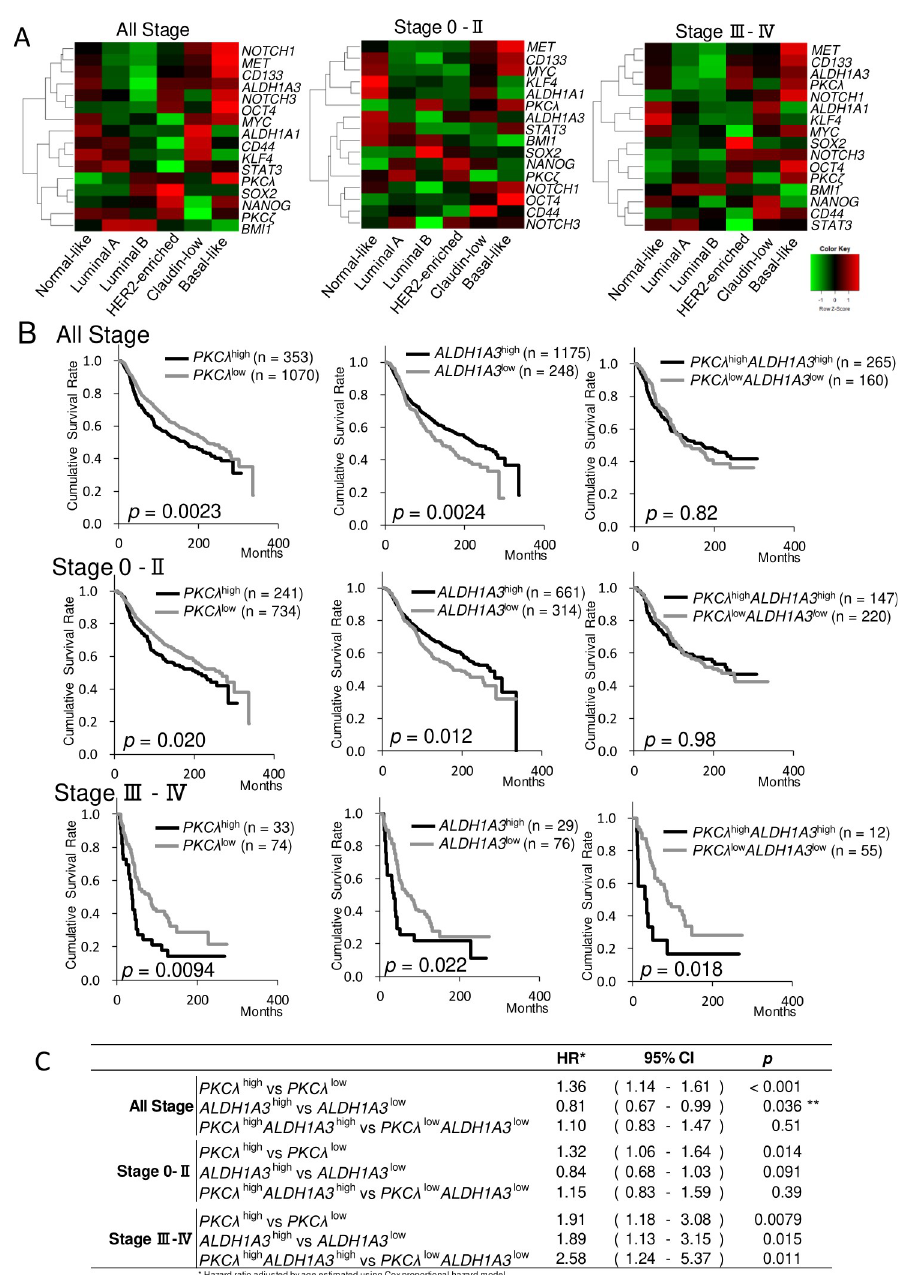
Fig 2. High expression of PKC λ and ALDH1A3 contributes to poor clinical outcomes in breast cancer patients. (A) Heatmaps of the average levels of PKC λ , PKC z , and stemness gene expression (z-score) in breast cancer PAM50 subtypes in the METABRIC dataset at several tumor stages. Raw z-scores were recalculated based on the average values. In the heatmap, red and green represent upregulated and downregulated genes, respectively: left panel, all stages; center panel, stages 0-II, right panel, stages III-IV. (B) Kaplan-Meier survival analysis of DSS in stage III-IV breast cancers from the METABARIC dataset. The p values were calculated using the log-rank test. (C) HRs for PKC λ and ALDH1A3 expression estimated using a multivariate Cox regression model for DSS among breast cancers at several tumor stages.